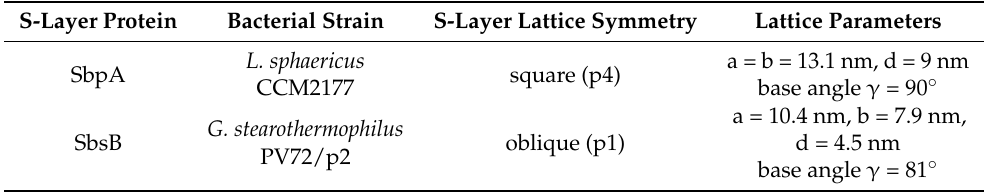
Table 1. Summary of the lattice parameters of the S-layer proteins, SbpA and SbsB, used in this work.